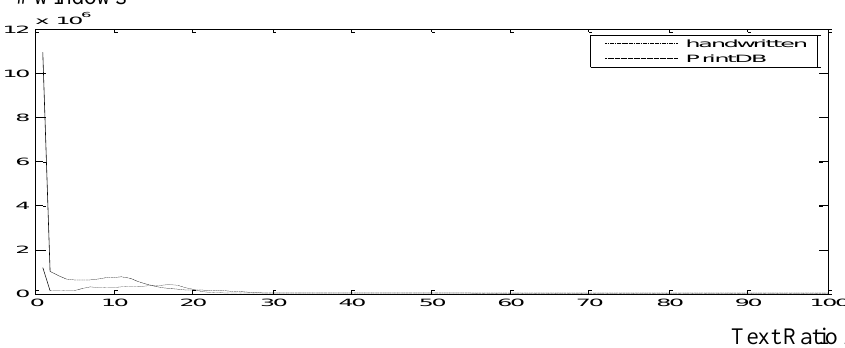
Figure 11. Number of windows according to text ratio in the window. The large amount close to zero corresponds to almost empty windows (background).